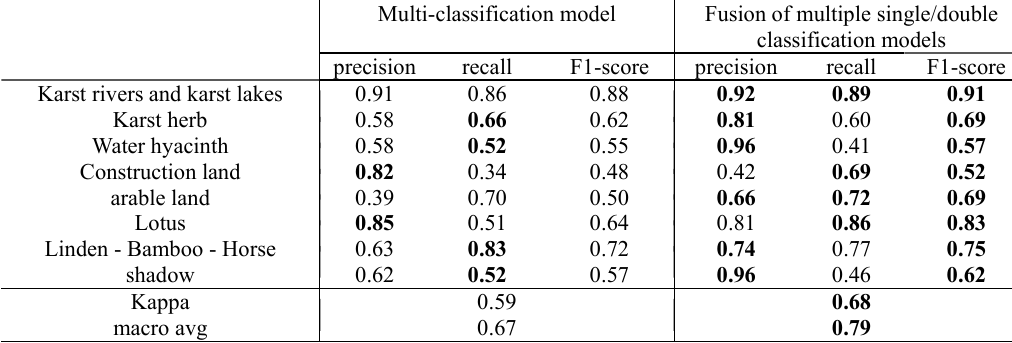
Table 2 Comparison of prediction results of multi-classification model and fusion single/double classification